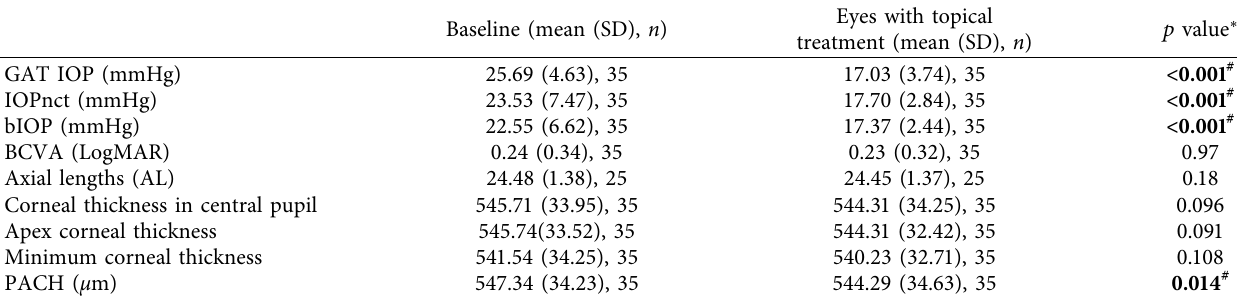
Table 2: Clinical characteristics in OHT patients with glaucoma medication